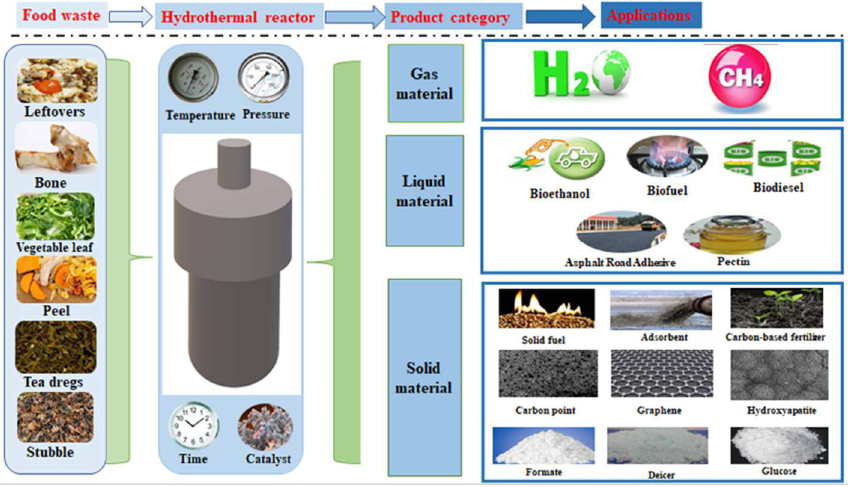
Figure 2. Schematic illustration of this